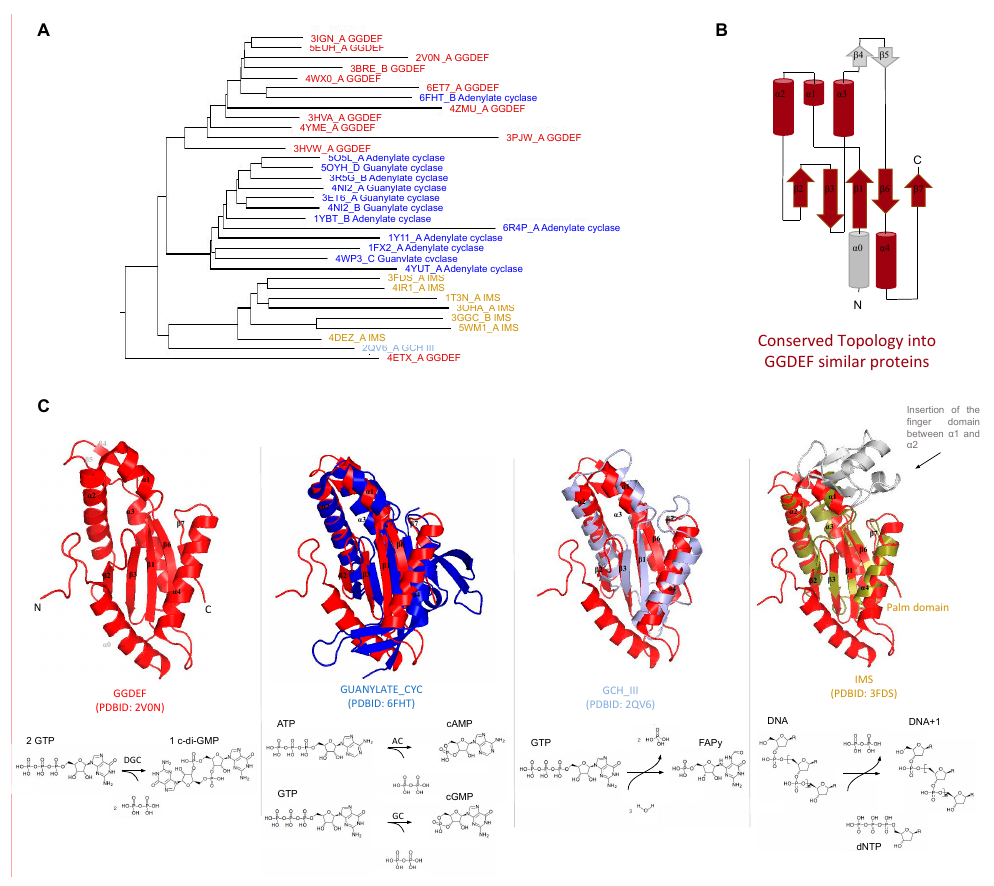
Figure 1. Structural similarities between GGDEF ( GG [ D / E][ E / D] F conserved sequence motif) domains and adenylate / guanylate cyclase, GTP (guanosine triphosphate) cyclohydrolase III and RRM-like